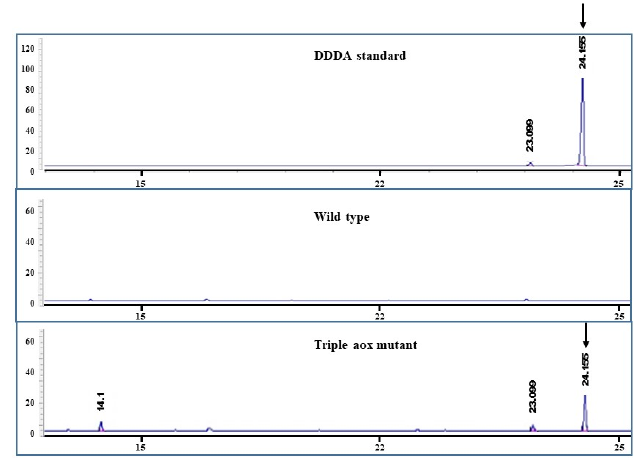
Figure 4. Gas Chromatography analysis for the detection of dodecanedioic acid (DDDA) from dodecane. DDDA peak was detected at 24.15 min from culture broth of triple aox mutant.